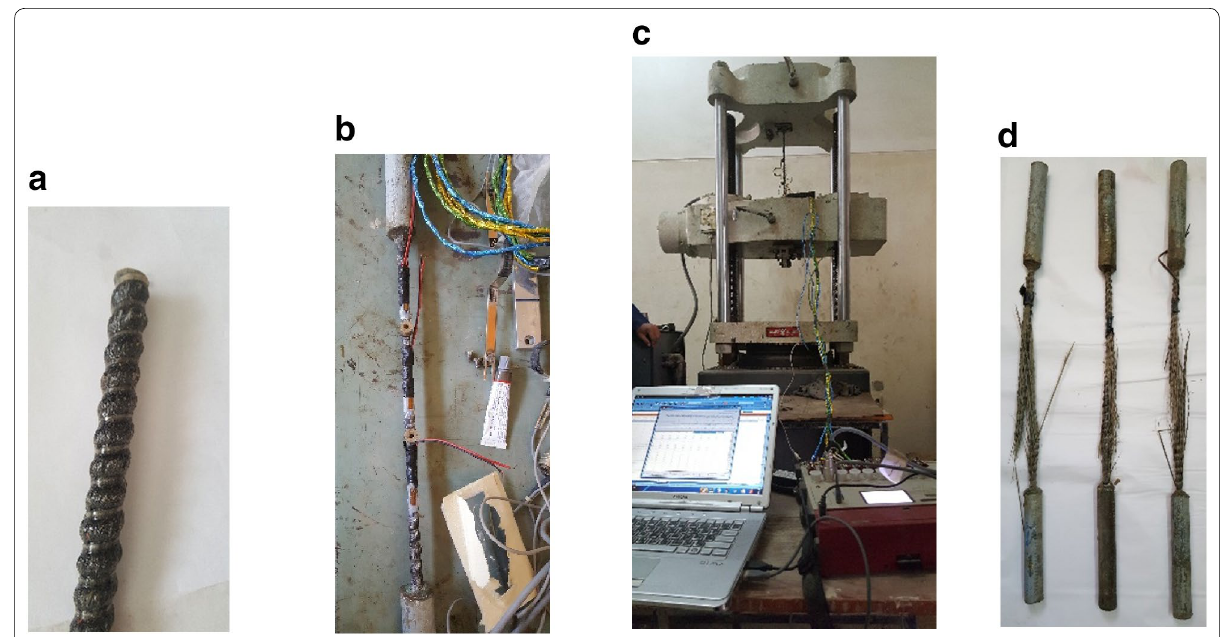
Fig. 2 Tension test of the BFRP bars: a BFRP bars used in strengthening; b specimen preparation; c test setup; and d mode of failure.